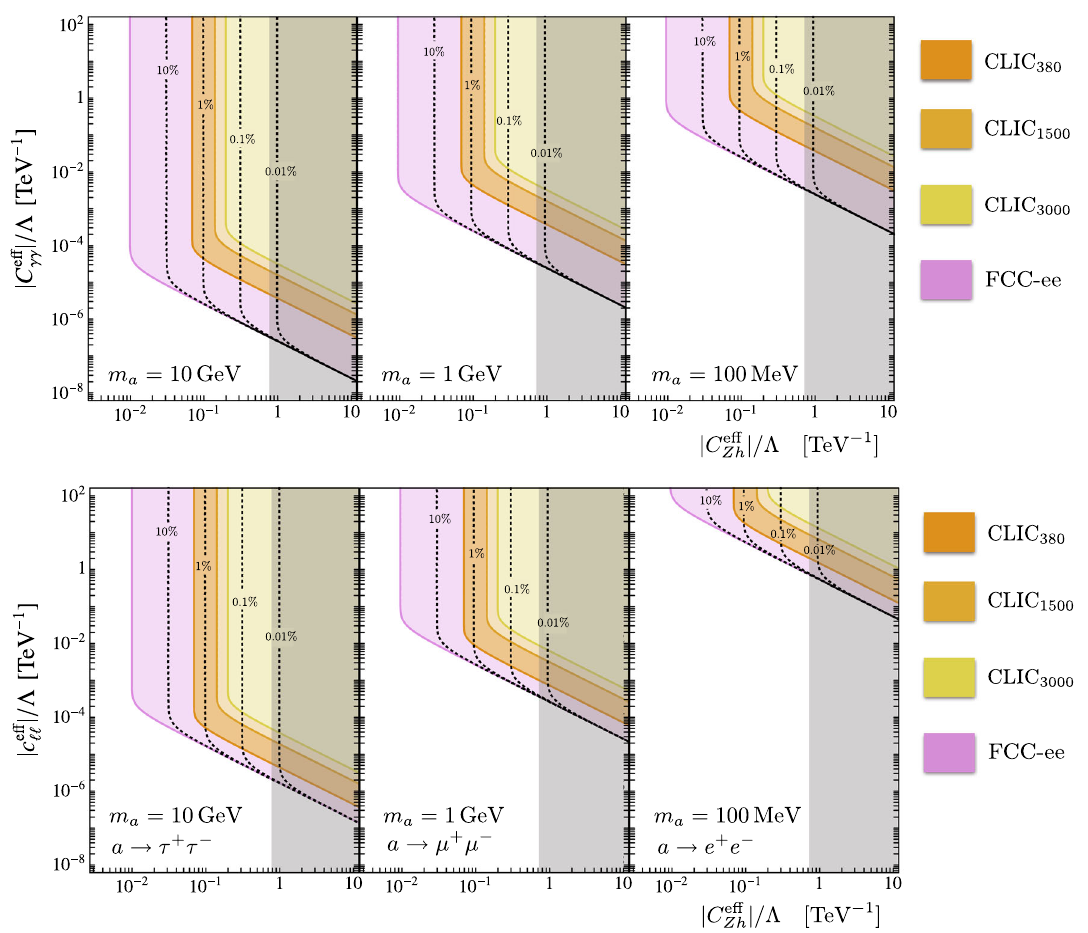
corresponds to the sensitivity reach of the FCC-ee with the indicated ALP branching ratios. The sensitivity regions are based on 4 expected signal